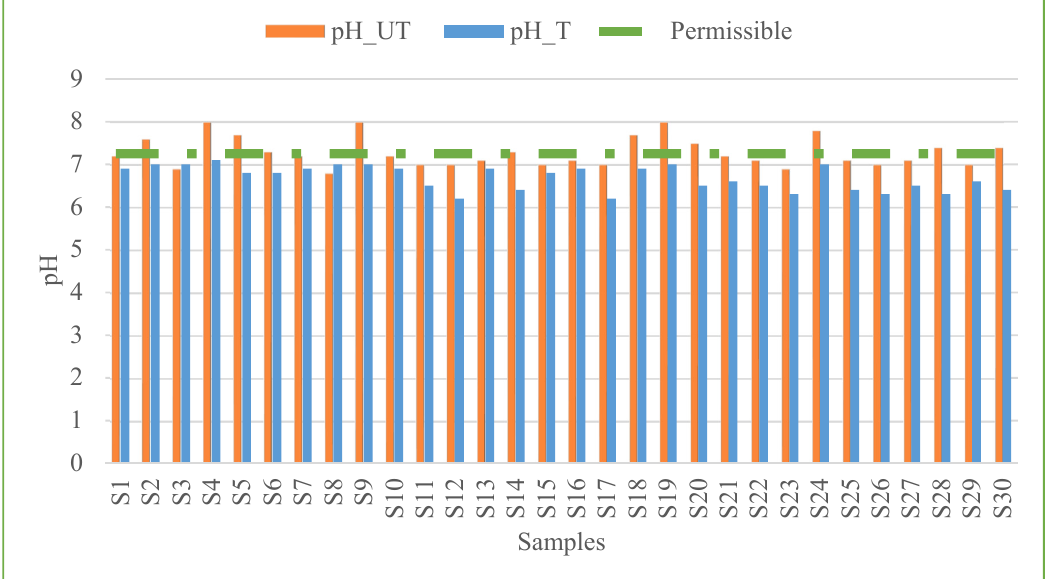
Figure 4. pH of untreated (UT) and treated (T) water samples and permissible limits.